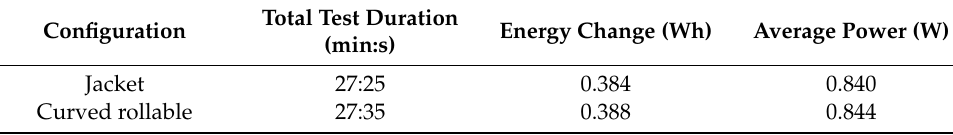
Table 9. Results of PV generator tests in real use, full overcast conditions.